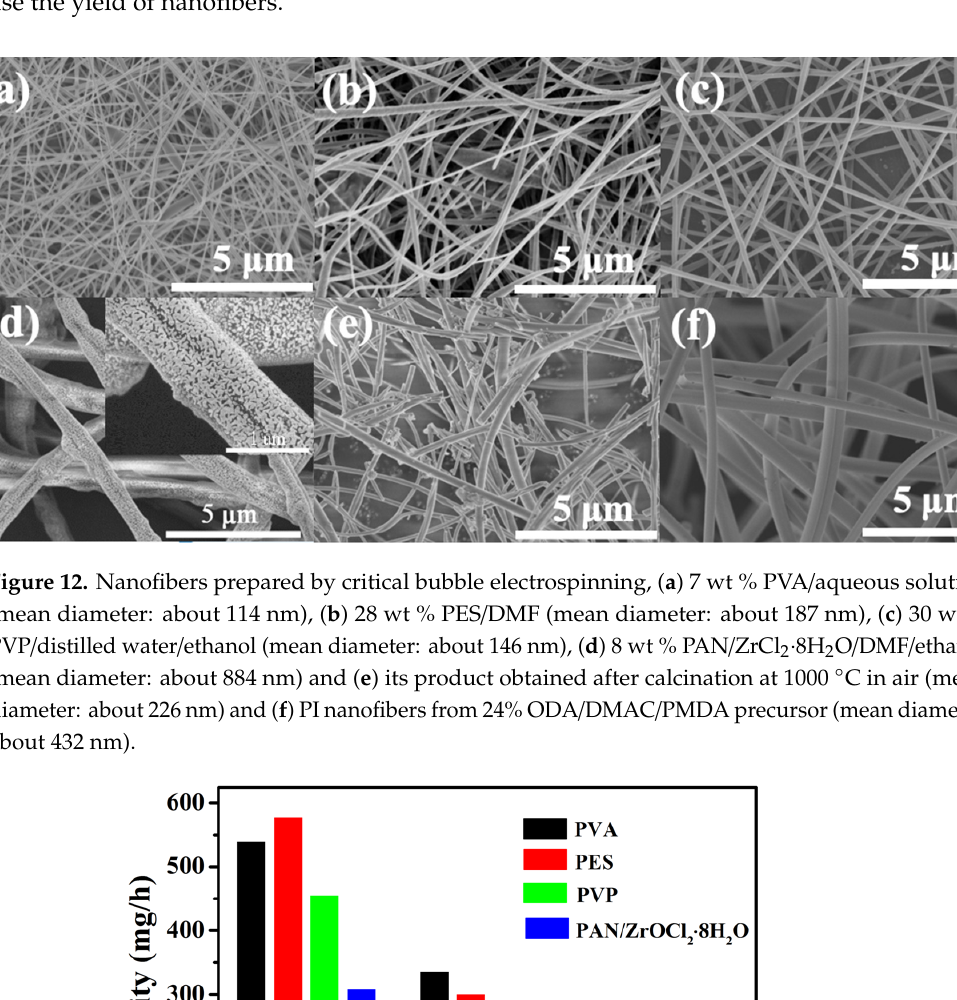
Figure 11. Schematic of hierarchical bubbles in critical bubble electrospinning.